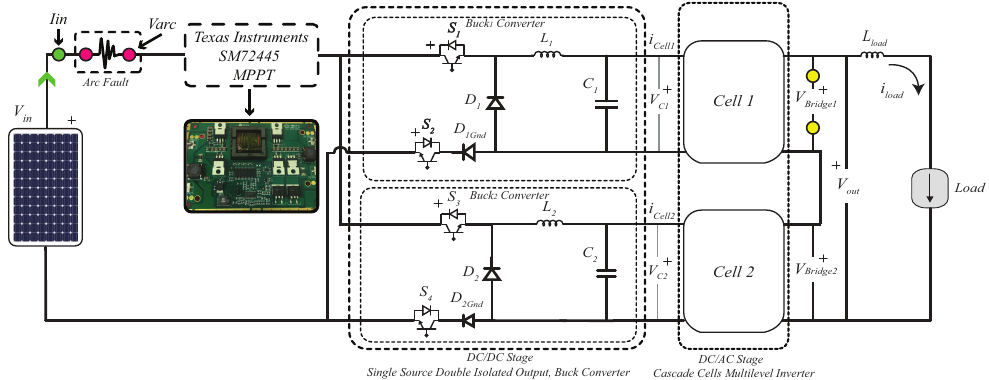
Figure 15. Schematic diagram for AF testing with the AF before the MPPT module. In this test, the data acquisition of three waveforms ( VBridge 1 (C1), V arc (C2) and I in (C3)) was performed, as shown in Figure 16. V arc is an essential signal to confirm if the fluctuations in C1 and C3 are related to the AF appearance.